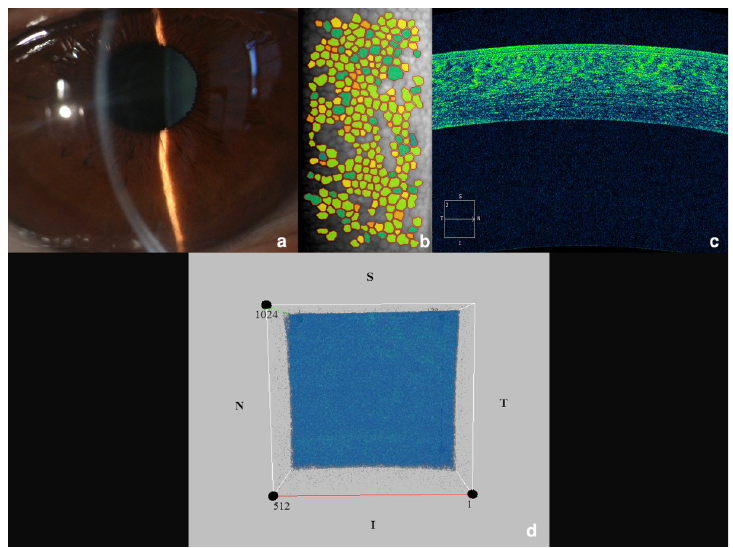
Fig 1. The study eye of a healthy subject and its related OCT pattern n. 1 (‘homogeneous’ appearance). (a) slit- lamp biomicroscopy; (b) specular endothelial microscopy; (c) cross-sectional AS-OCT image confirming a normal corneal structure; (d) 3D AS-OCT image of a 512x128 cube scan showing a homogenous reflectivity of the inner corneal surface, with no hyper-reflective points/areas.